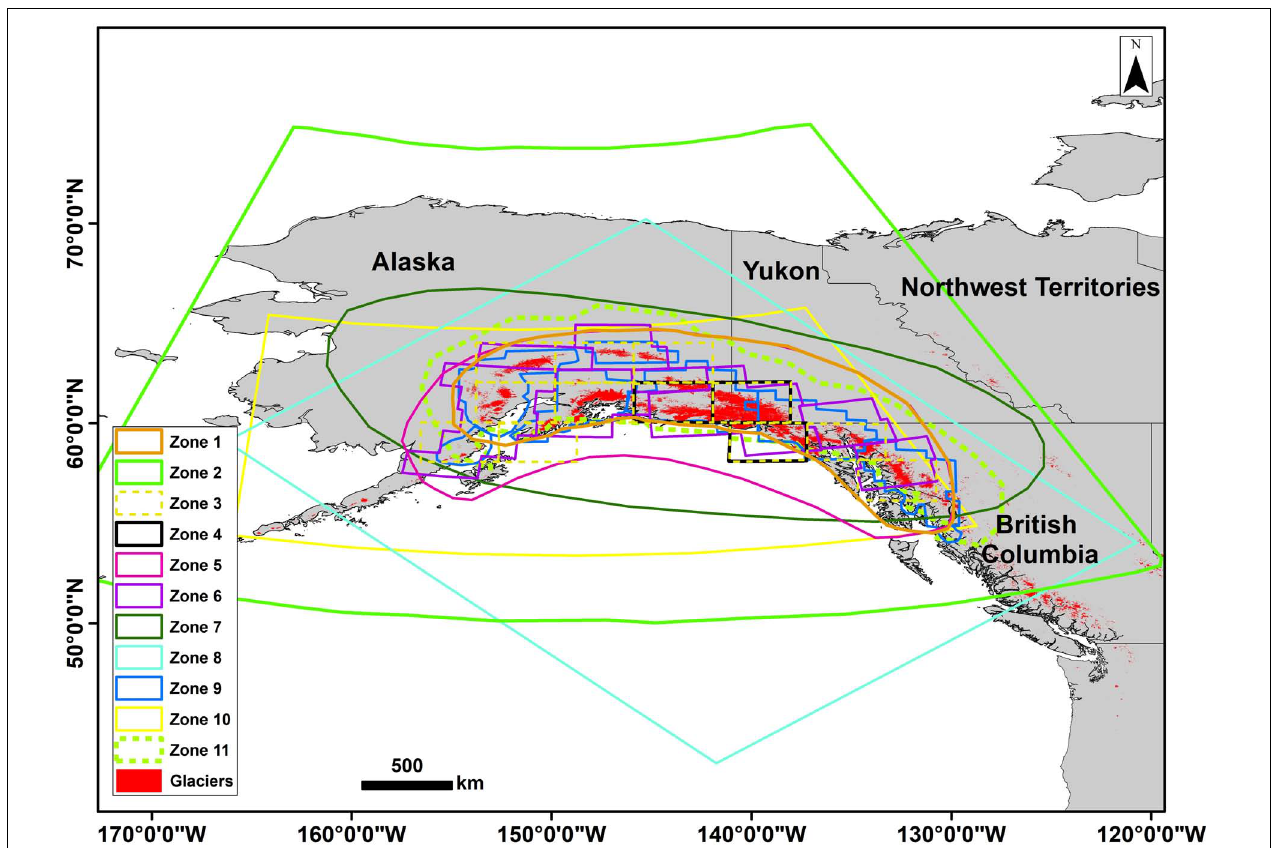
FIGURE 1 | Glaciers of the GOA and footprints of the study area considered in studies using GRACE data to assess glacier melt. The study area considered here is identified as Zone 11.